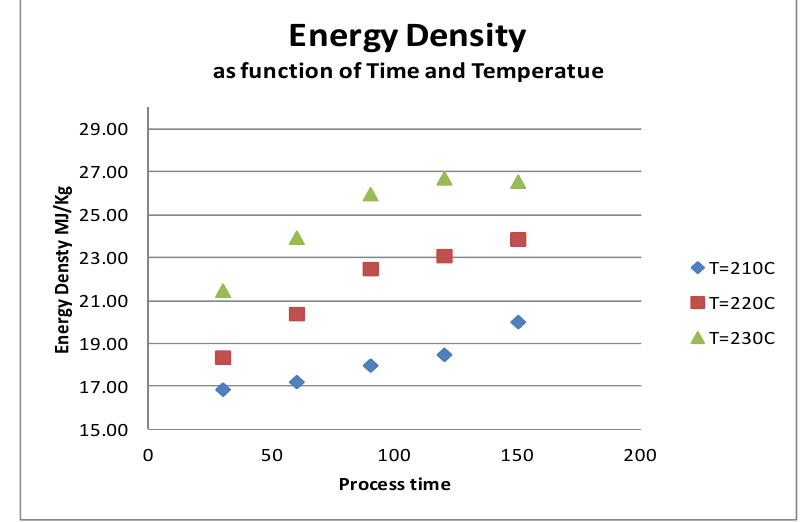
Figure 7. Energy density of HTP catalyst biofuel from cotton as a function of time and temperature. The HTP catalyst concentration was 2 g/L.